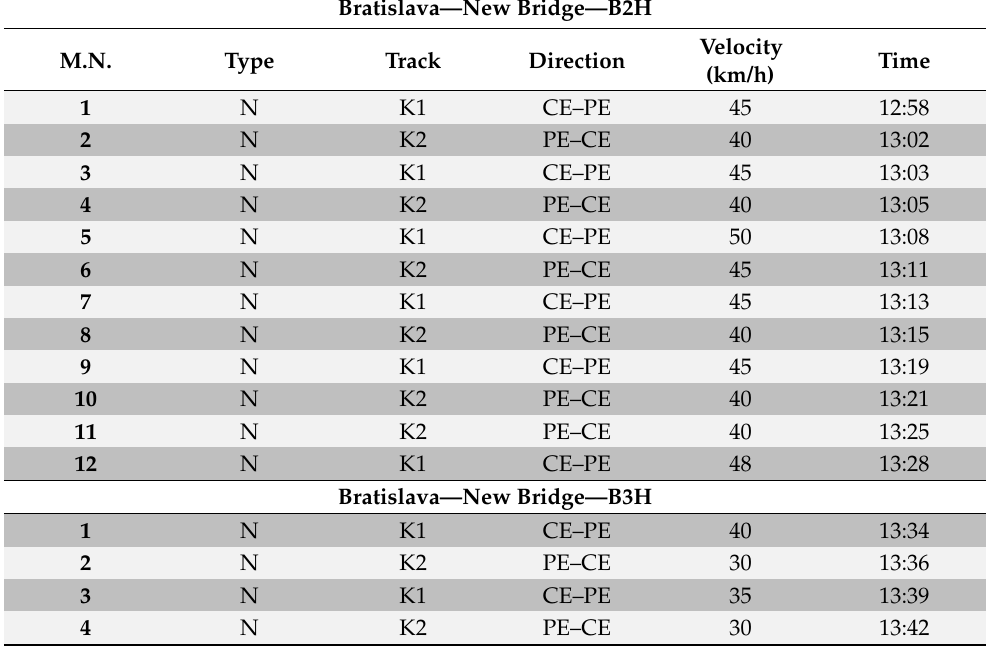
Table 5. Overview of noise measurement data on the New Bridge, in the B2H and B3H localities. Bratislava—New Bridge—B2H